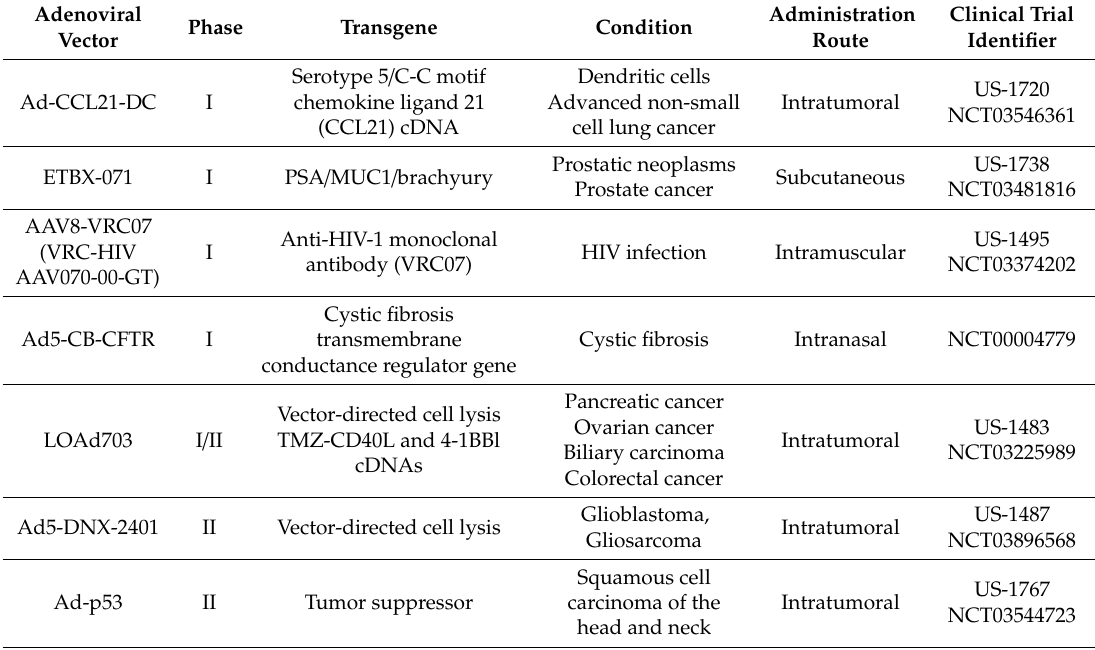
Table 2. Ad vectors currently used in gene therapy clinical trials in the U.S.